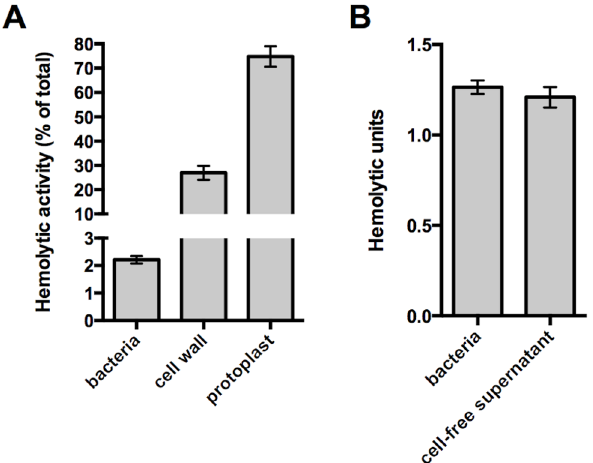
Fig 1. The native cell wall inhibits Ply activity and release. (A) Washed whole cells, subcellular fractions (cell wall and protoplast), or sonicated cell lysates of wildtype pneumococcus were tested for hemolytic activity as described in Materials and Methods . Protoplasts were lysed by sonication prior to the experiment. The hemolytic activity of each sample is represented as a percent of the total as determined for the sonicated cell lysate. (B) To determine if the activity of intact cells is due to cell-associated or secreted Ply, washed whole cells were incubated with SRBCs or buffer alone for one hour. Cells incubated with buffer alone were pelleted and the cell-free supernatant was removed and tested for hemolytic activity as described in Materials and Methods . Of note, Ply is the only active hemolysin under these conditions; deletion of ply completely abolishes hemolytic activity. Columns represent the mean and error bars denote SEM of at least four (A) or two (B) biological